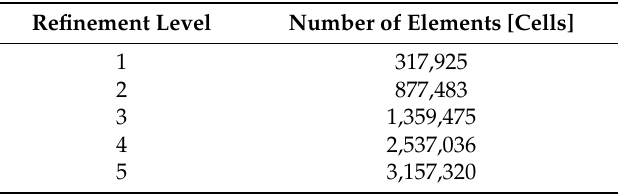
Table 5. Mesh sensitivity